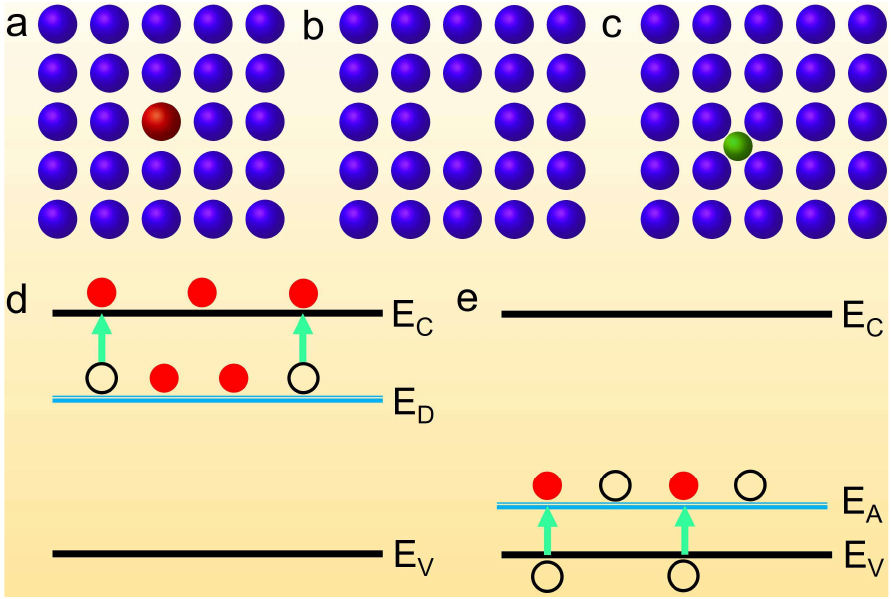
Figure 1. Classical type of semiconductor doping. ( a ) Substitutional doping formed in semiconductors. The blue and red balls in the schematic stand for the intrinsic and substitutional atoms in the semiconductor. ( b ) Vacancy defects formed in semiconductors. ( c ) Interstitial doping formed in semiconductors. The blue and green balls in the schematic stand for the intrinsic and interstitial atoms in the semiconductor. ( d , e ) The ionization process of the donor and acceptor impurity can be represented by a band diagram, respectively. E C is conduction band minimum level, E V is Valence band maximum level, E D is donor level, and E A is acceptor level. Red and black balls represent electrons and holes, respectively.